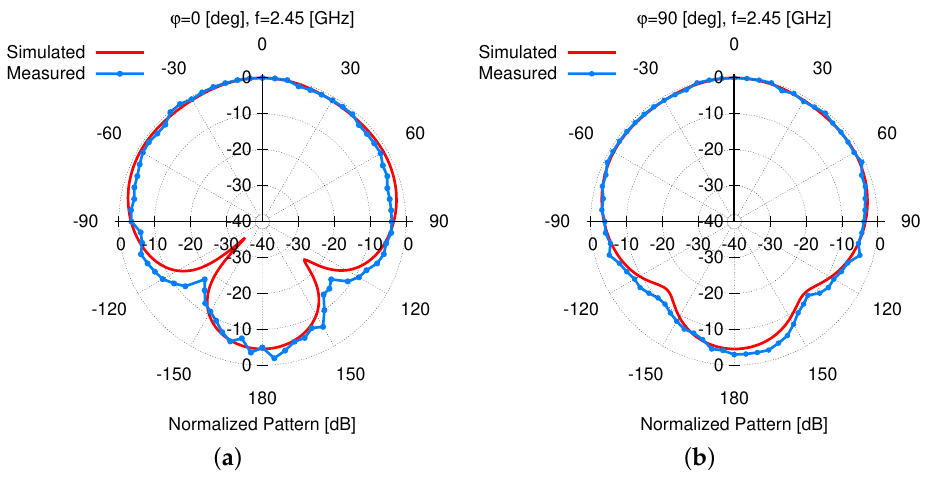
Figure 21. Experimental Assessment —Comparison between the simulated and measured patterns at f = f 0 = 2.45 [GHz] along the elevation cuts ( a ) ϕ = 0 [deg] and ( b ) ϕ = 90